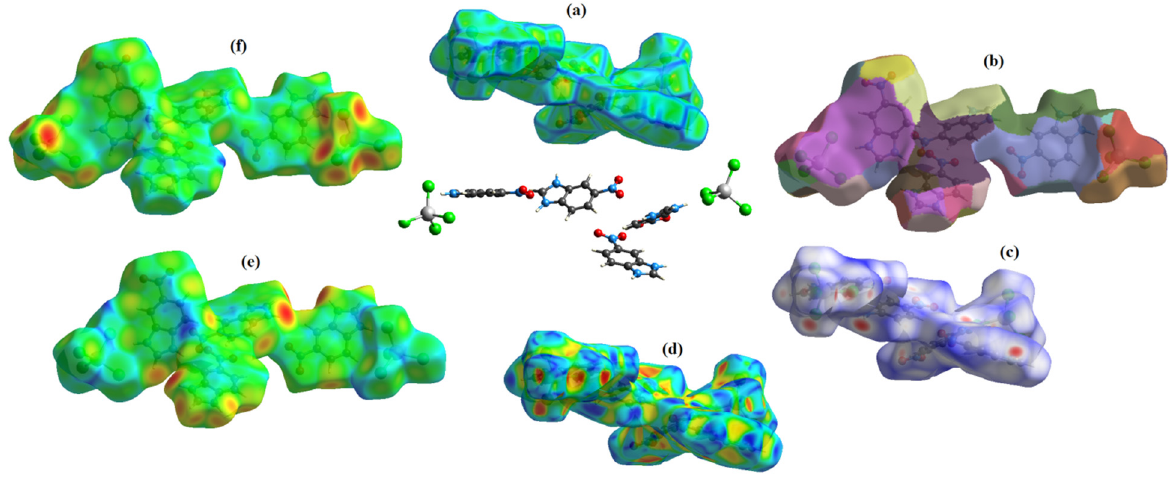
Figure 4. ( a ) Curvedness surface, ( b ) patch fragment surface, ( c ) d norm surface, ( d ) shape index surface, ( e ) d i and ( f ) d e of (C 7 H 6 N 3 O 2 ) 2 [ZnCl 4 ].